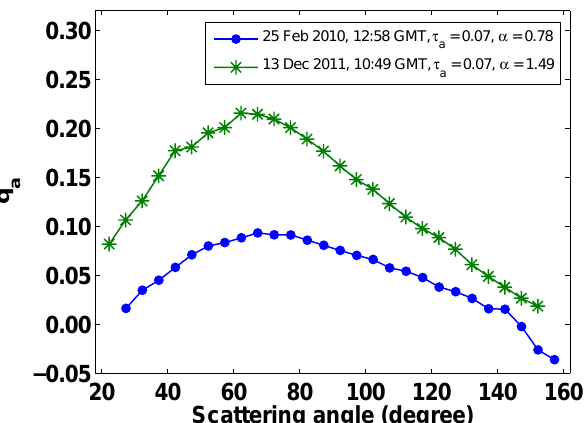
Fig. 5. Strong positive correlation between q a ( max ) at 870nm and α . Colors are mapped to τ a on the logarithmic scale, February 2010 to December 2012, IASBS